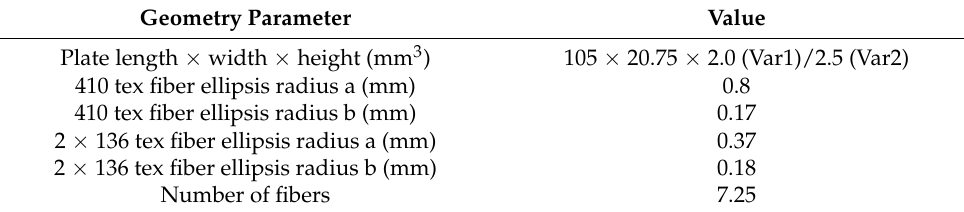
Table 2. Geometry modeling